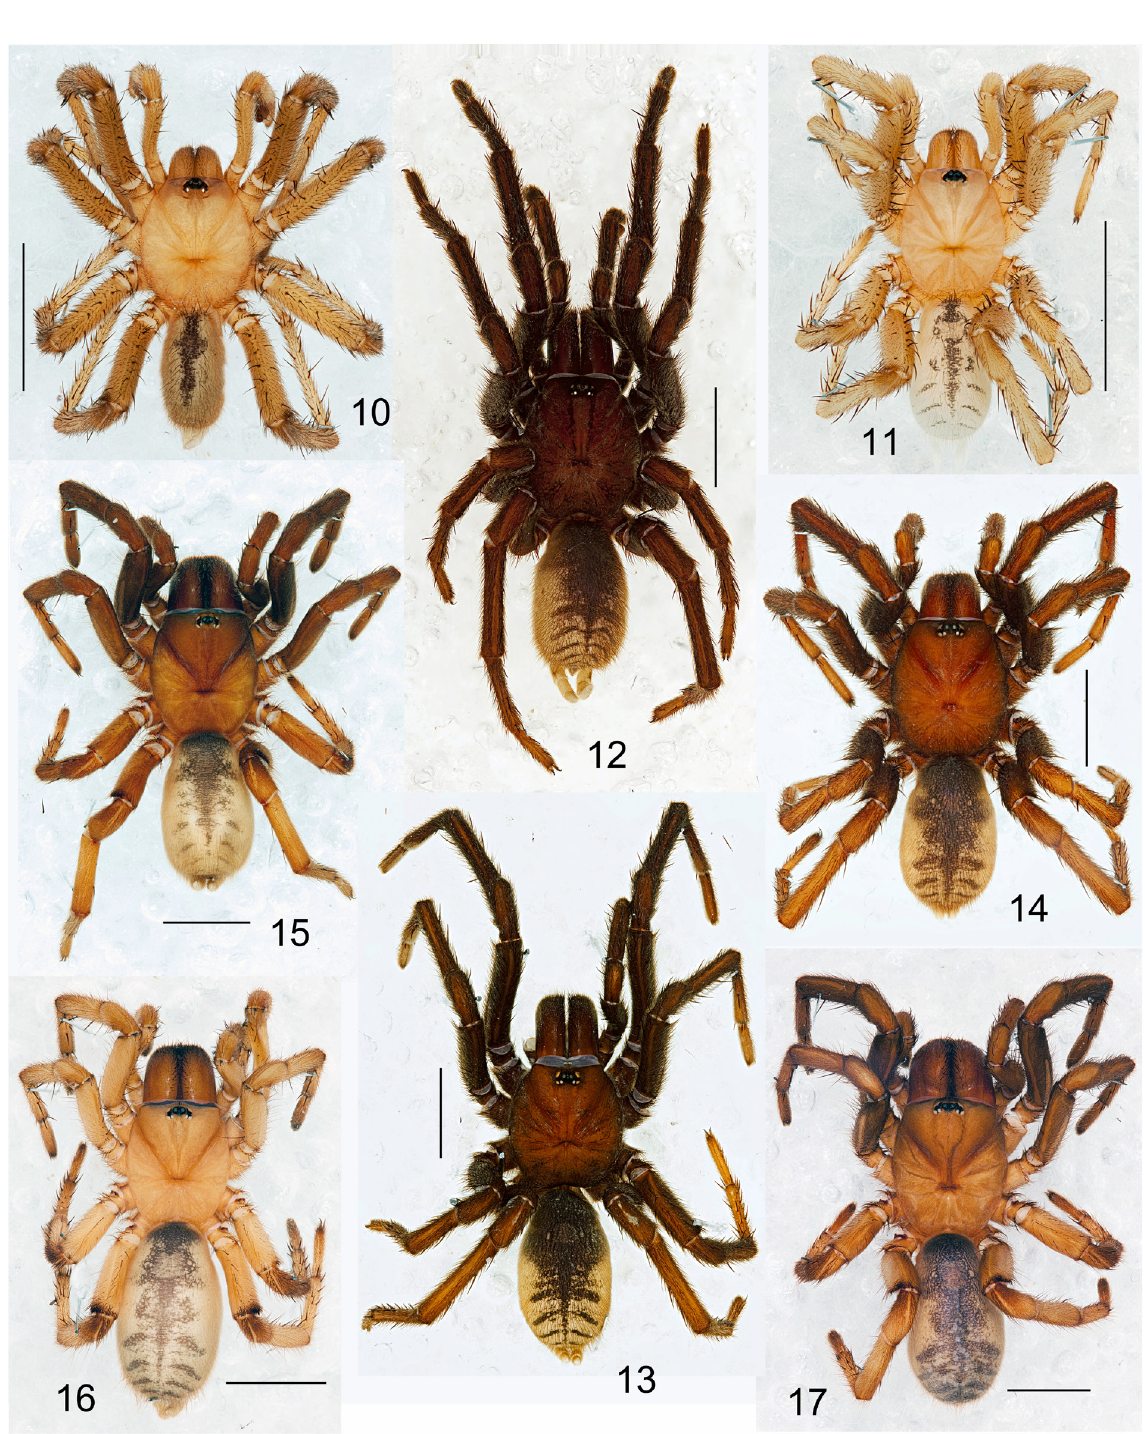
Figs 10–17. Anemesia spp., ♂♂ (10–14) and ♀♀ (15–17), habitus, dorsal views. 10 . A. pallida sp.